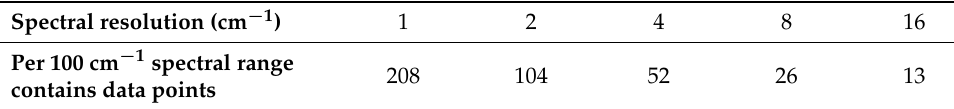
Table 1. Spectral resolution and data points after